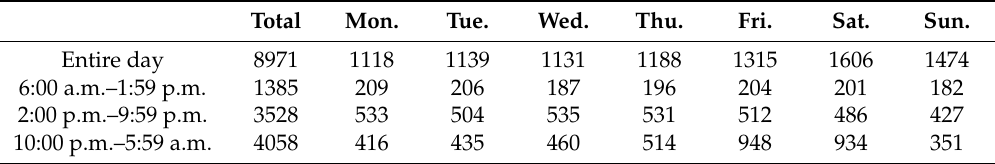
Table 1. Absolute numbers of street robberies in Vienna, Austria from 2009 to 2013 by time of day and by weekday. Total Mon. Tue. Wed. Thu. Fri. Sat. Sun.